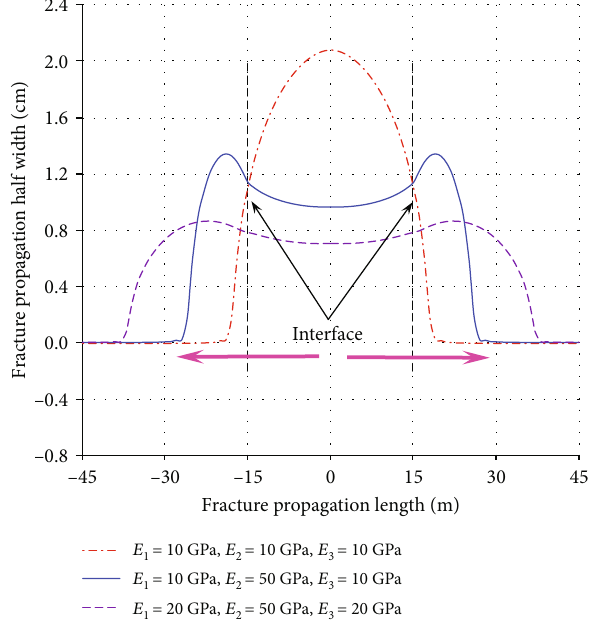
Figure 9: E ff ect of modulus contrast on the fracture propagation